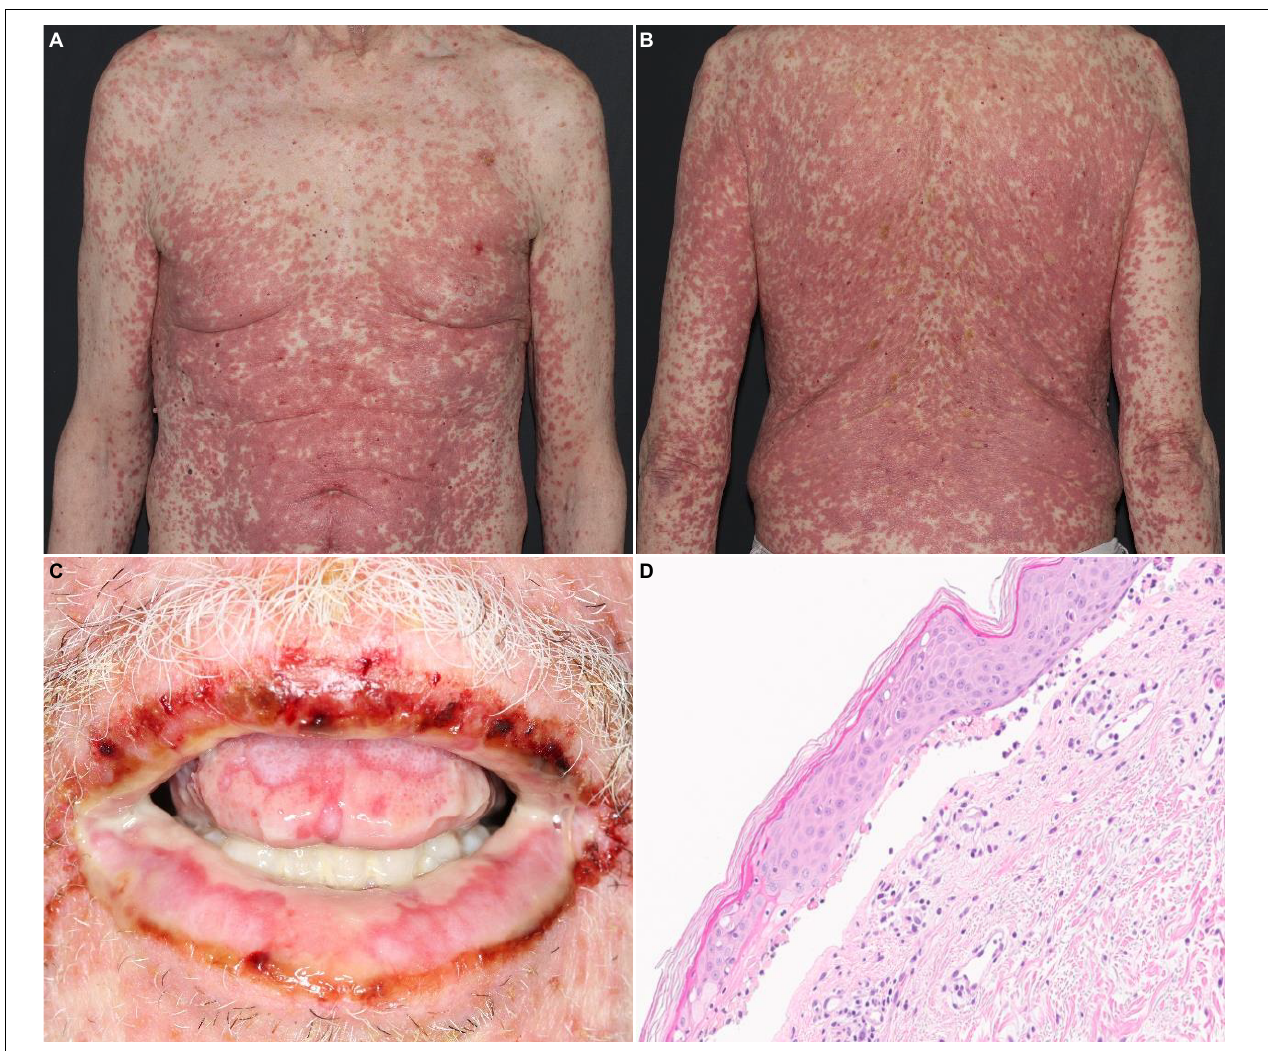
FIGURE 1 | SJS/TEN-like reaction with erythematous macules and papules with dusky, purpuric centers covering about 80% BSA on the (A) trunk and (B) back. (C) Desquamation and hemorrhagic crusts on the oral mucosa. (D) Histology revealing lichenoid and subepidermal vesicular dermatitis with epidermal